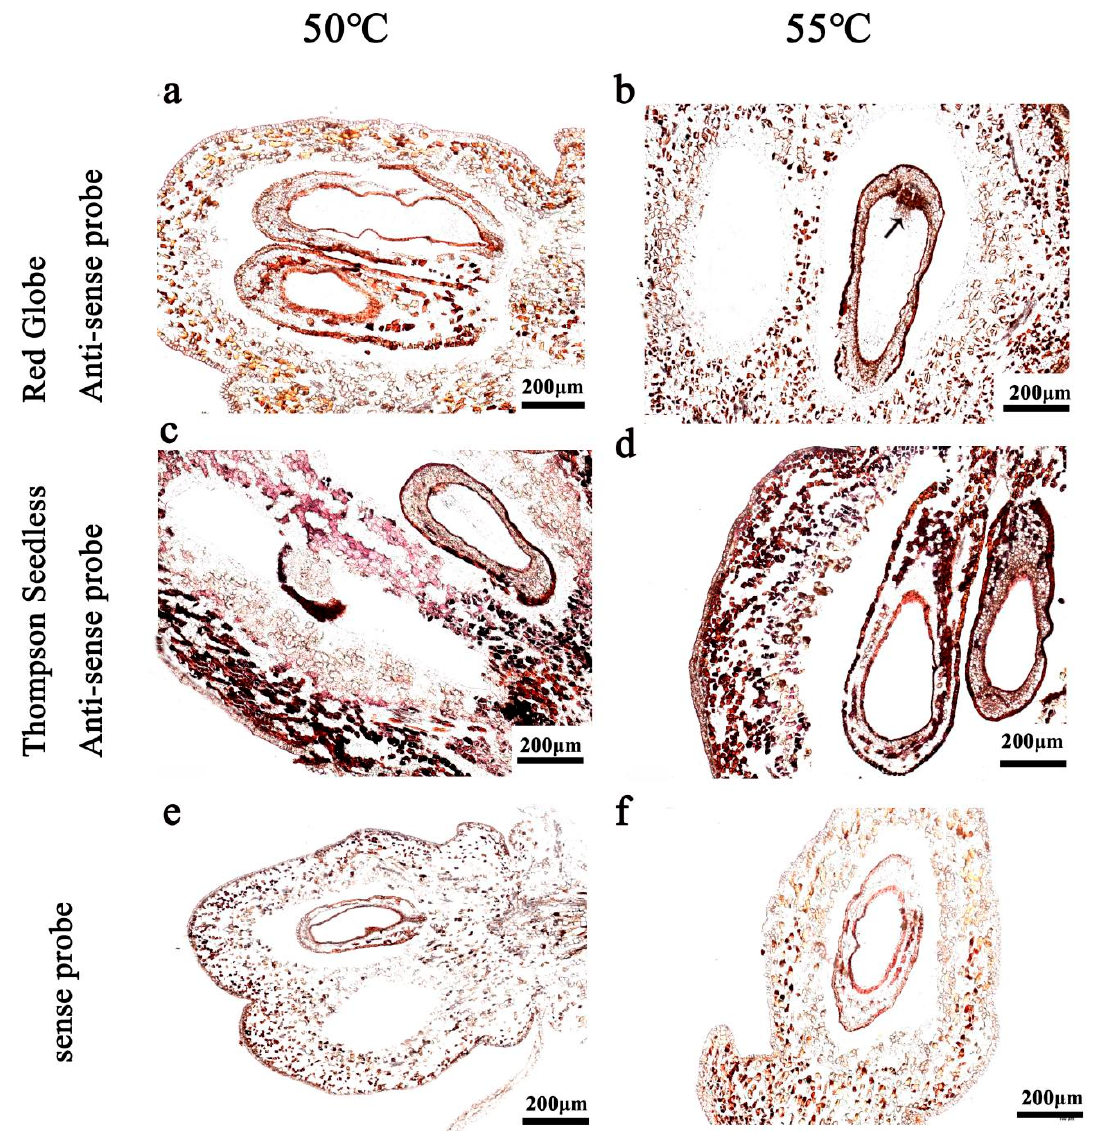
Figure 4. The in situ hybridisation with different hybridisation temperatures. The hybridisation temperatures were used included 50 °C ( a , c , e ) and 55 °C ( b , d , f ). ( a , b ): antisense probe, 10 DAF in ‘Red Globe’; ( c , d ): antisense probe, 10 DAF in ‘Thompson Seedless’; ( e , f ): sense probe. DAF: days after flowering.